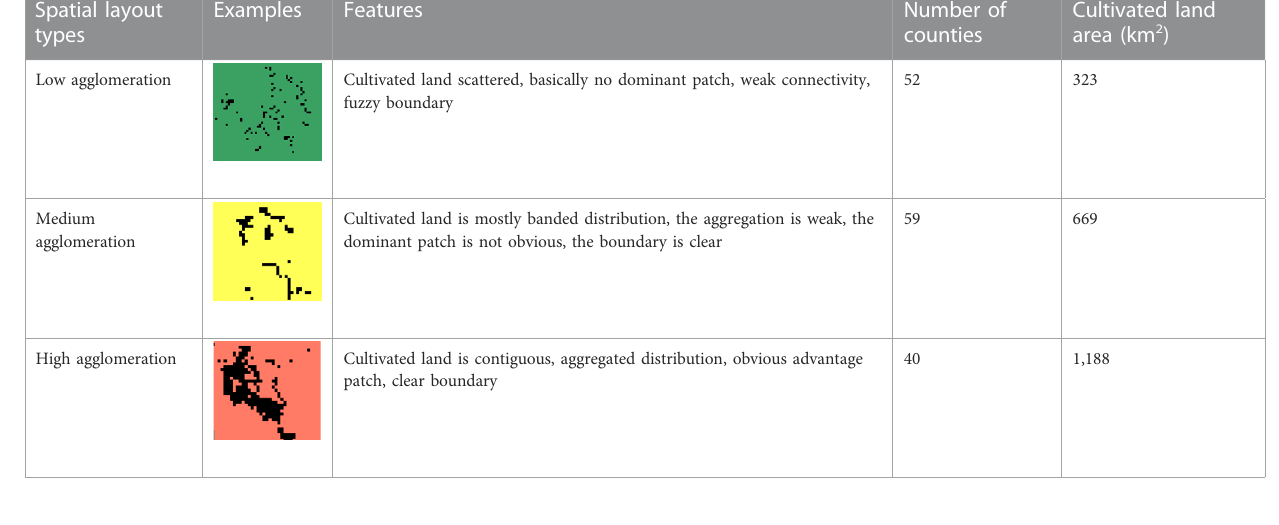
TABLE 3 Types and characteristics of the spatial layout of cultivated land at the county scale on the Qinghai-Tibet Plateau. Spatial layout types